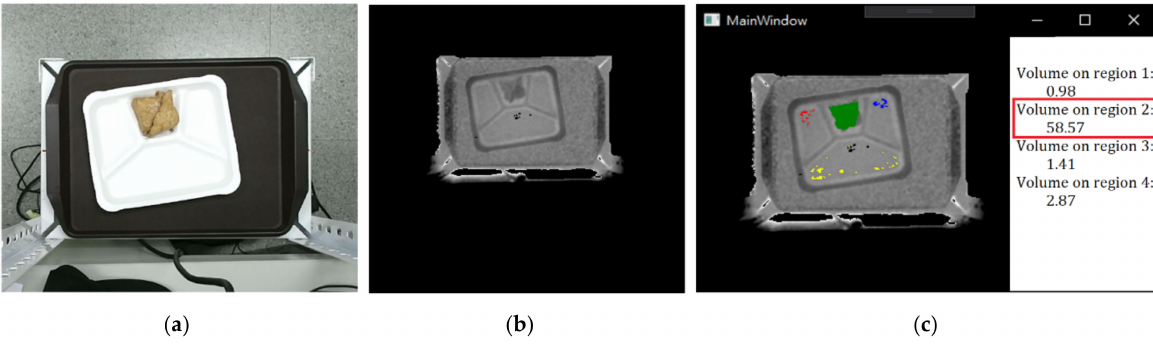
Figure 10. Food volume estimation. ( a ) RGB image, ( b ) the corresponding depth image, and ( c ) the estimated volumes on different